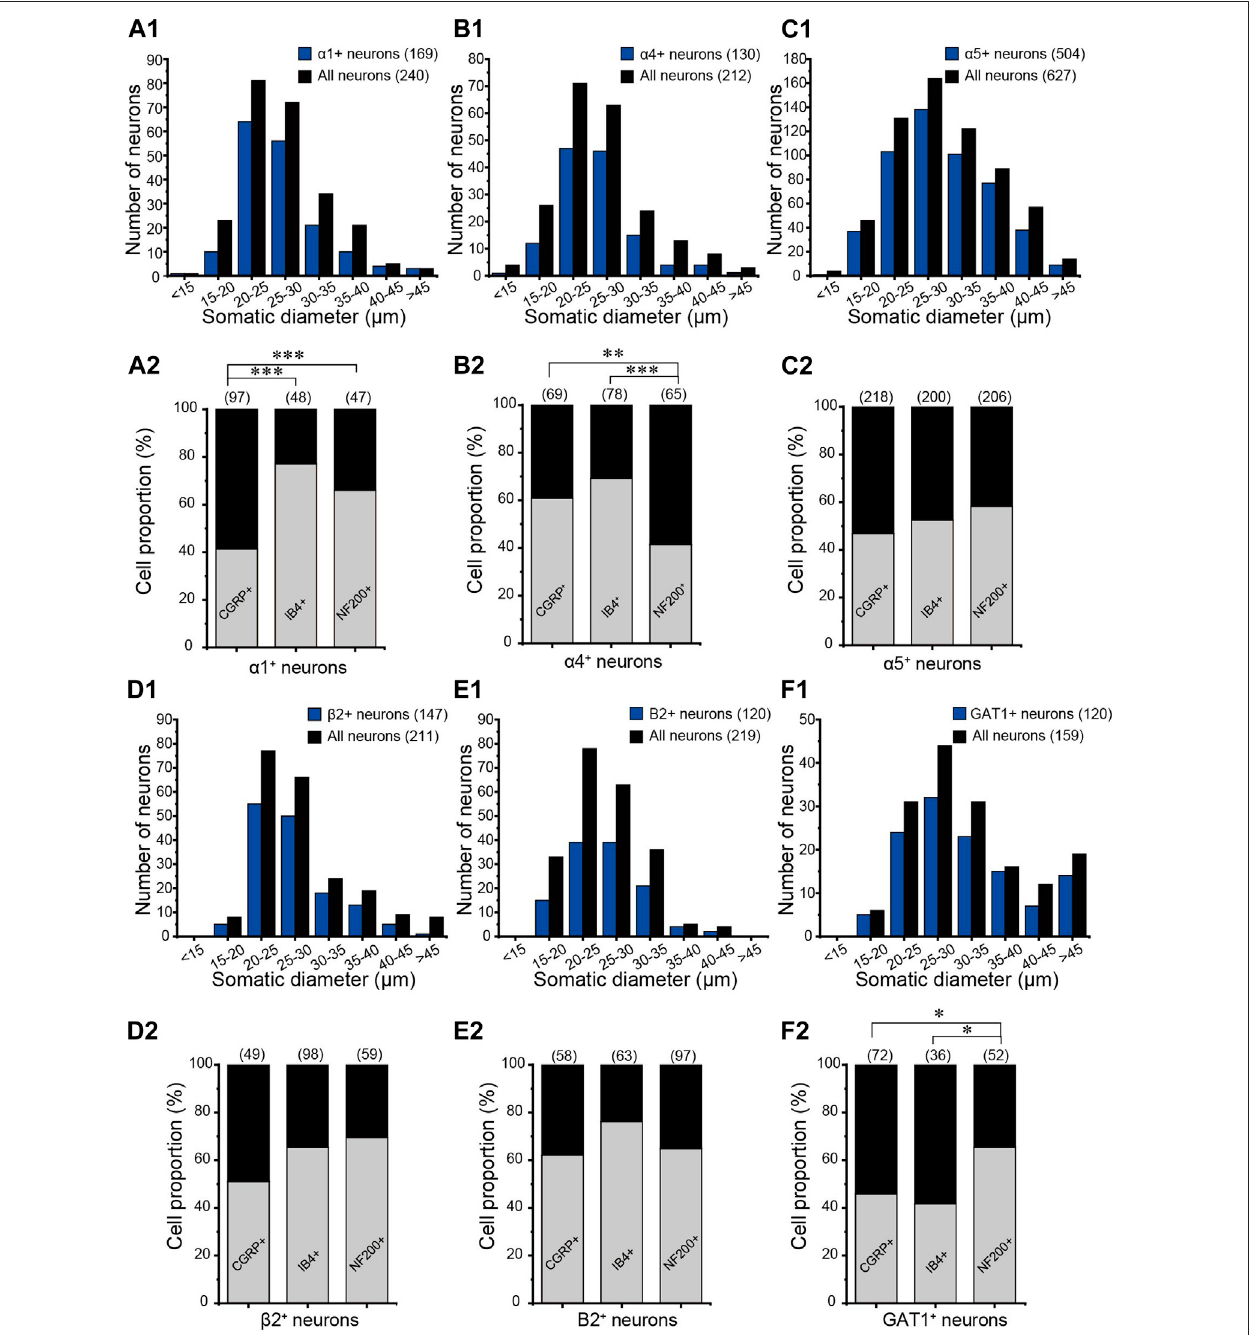
FIGURE 2 | Distributions of GABA-related proteins in DRG neurons. The somatic diameters of neurons positive for α 1 (A1) , α 4 (B1) , α 5 (C1) , and β 2 (D1) of the GABA A receptor, B2subunit ofthe GABA B receptor (E1) , and GAT1 (F1) were measured and plotted assize-distribution histograms. Percentages of CGRP-, IB4-,and NF200-positive neurons in each GABA-related protein – positive DRG neuron were shown in (A2 – F2) , respectively. * p < 0.05, ** p < 0.01, *** p < 0.001 (Pearson ’ s chisquare